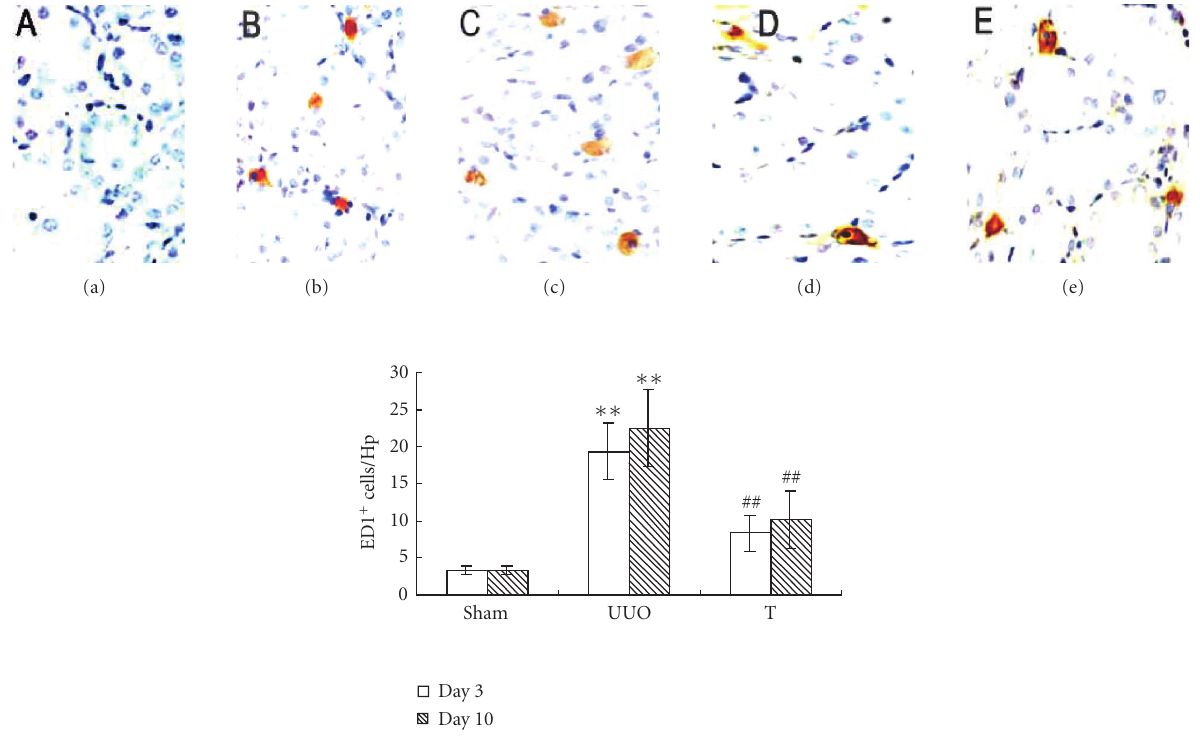
Figure 1: ED1 + cell accumulation at di ff erent time points in three groups ( × 400). Sections were stained using a standard three-layer method as recommended by SP kit. Macrophage accumulation was measured by immunohistochemistry and quantified by the number of ED1 + cells/HP: (a) sham group, (b) UUO on day 3, (c) UUO on day 10, (d) treatment group on day 3, and (e) treatment group on